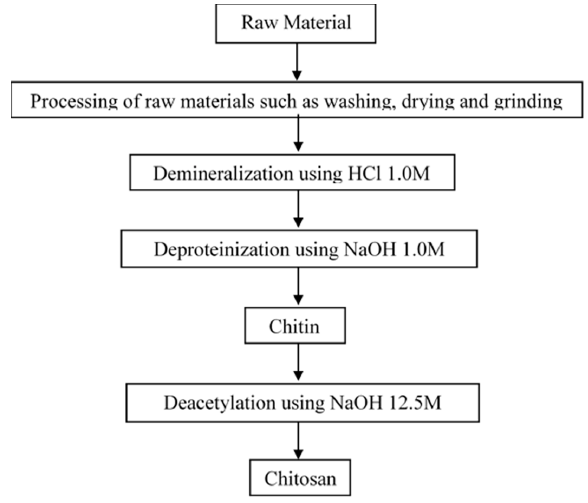
Figure 3. Flow of conventional preparation of chitosan.